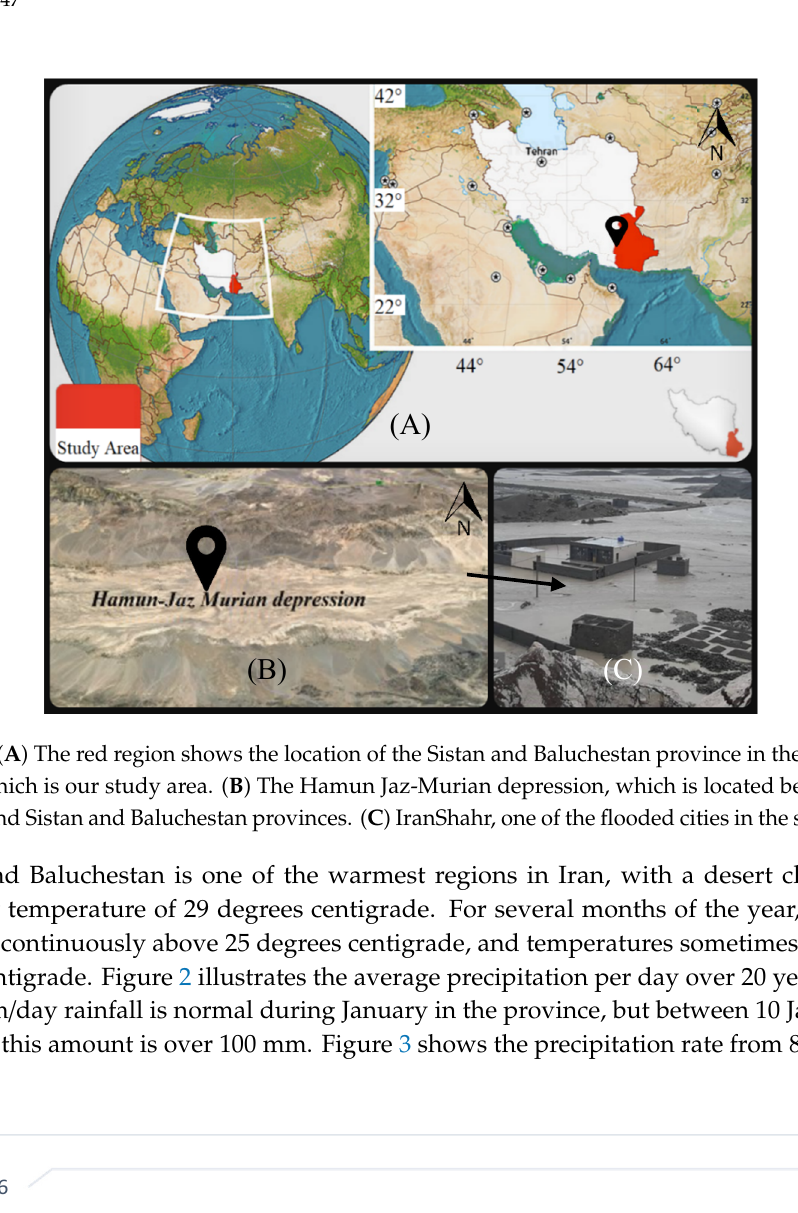
Figure 2. Average daily precipitation data collected from three meteorological stations in the Sistan and Baluchestan province based on the average values of the last 20 years[36].